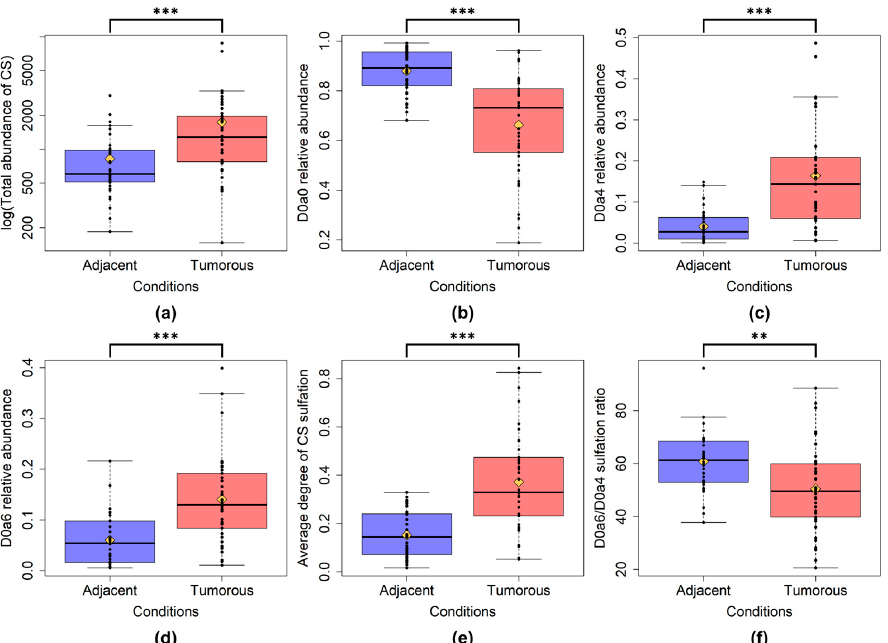
Figure 2. Box plots of altered CS characteristics between all adjacent and all tumor samples. ( a ): total CS quantity; ( b ): D0a0 relative abundance; ( c ): D0a4 relative abundance; ( d ): D0a6 relative abundance. ( e ): average degree of sulfation; ( f ): 6- O -/4- O -sulfation ratio. The yellow diamonds are the average values of the given sample groups. (**: p < 0.01; ***: p < 0.001).